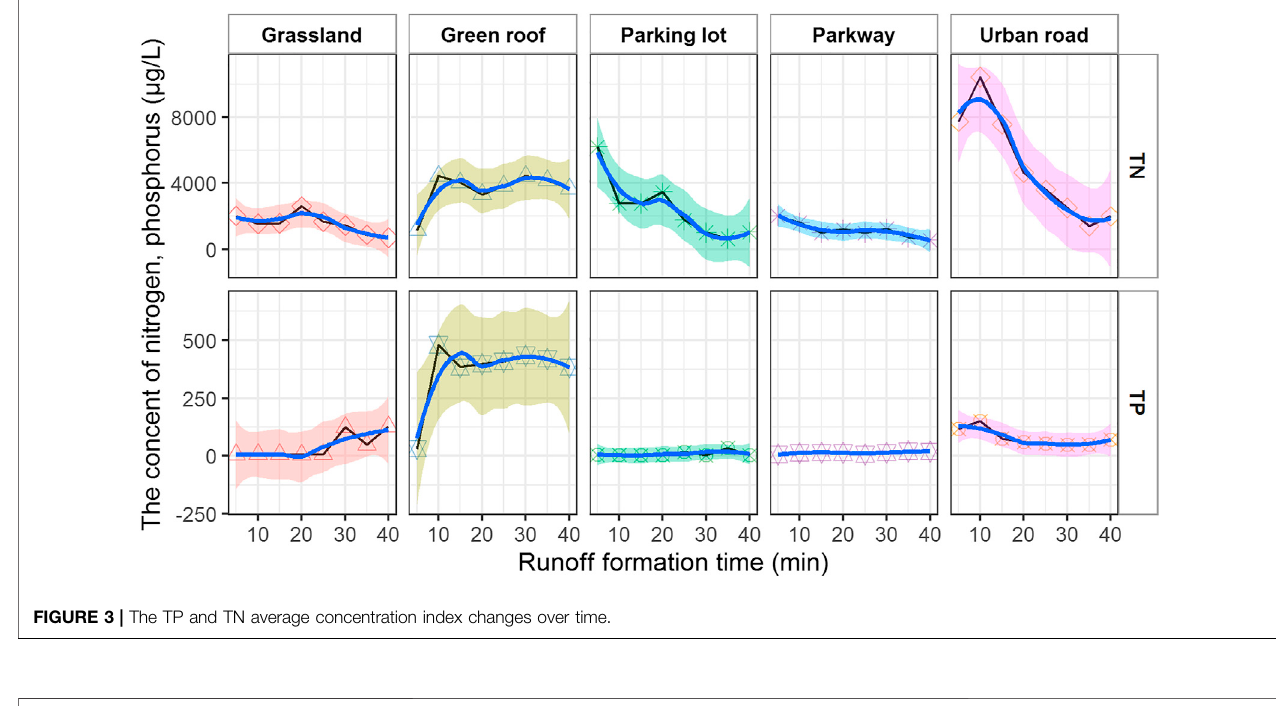
FIGURE 3 | The TP and TN average concentration index changes over time.